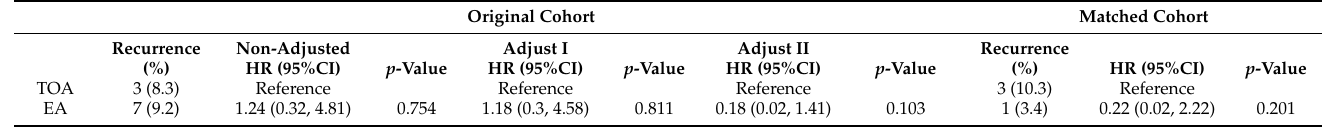
Table 3. Association between surgical approaches and recurrence before and after PSM. Original